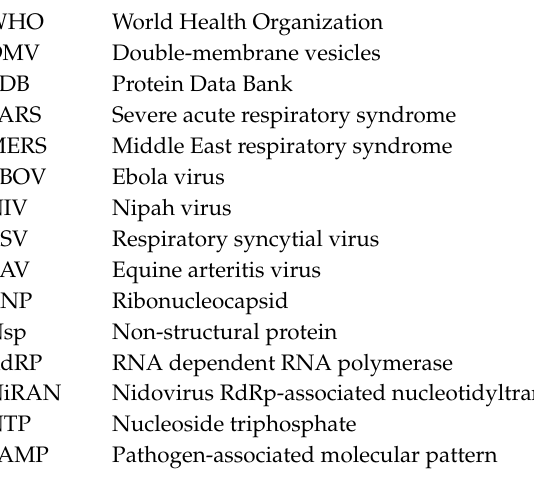
Figure S1: Model of SARS-CoV-2 elongation complex, Table S1: Sequence identities of SARS-CoV2 Nsps with homologous